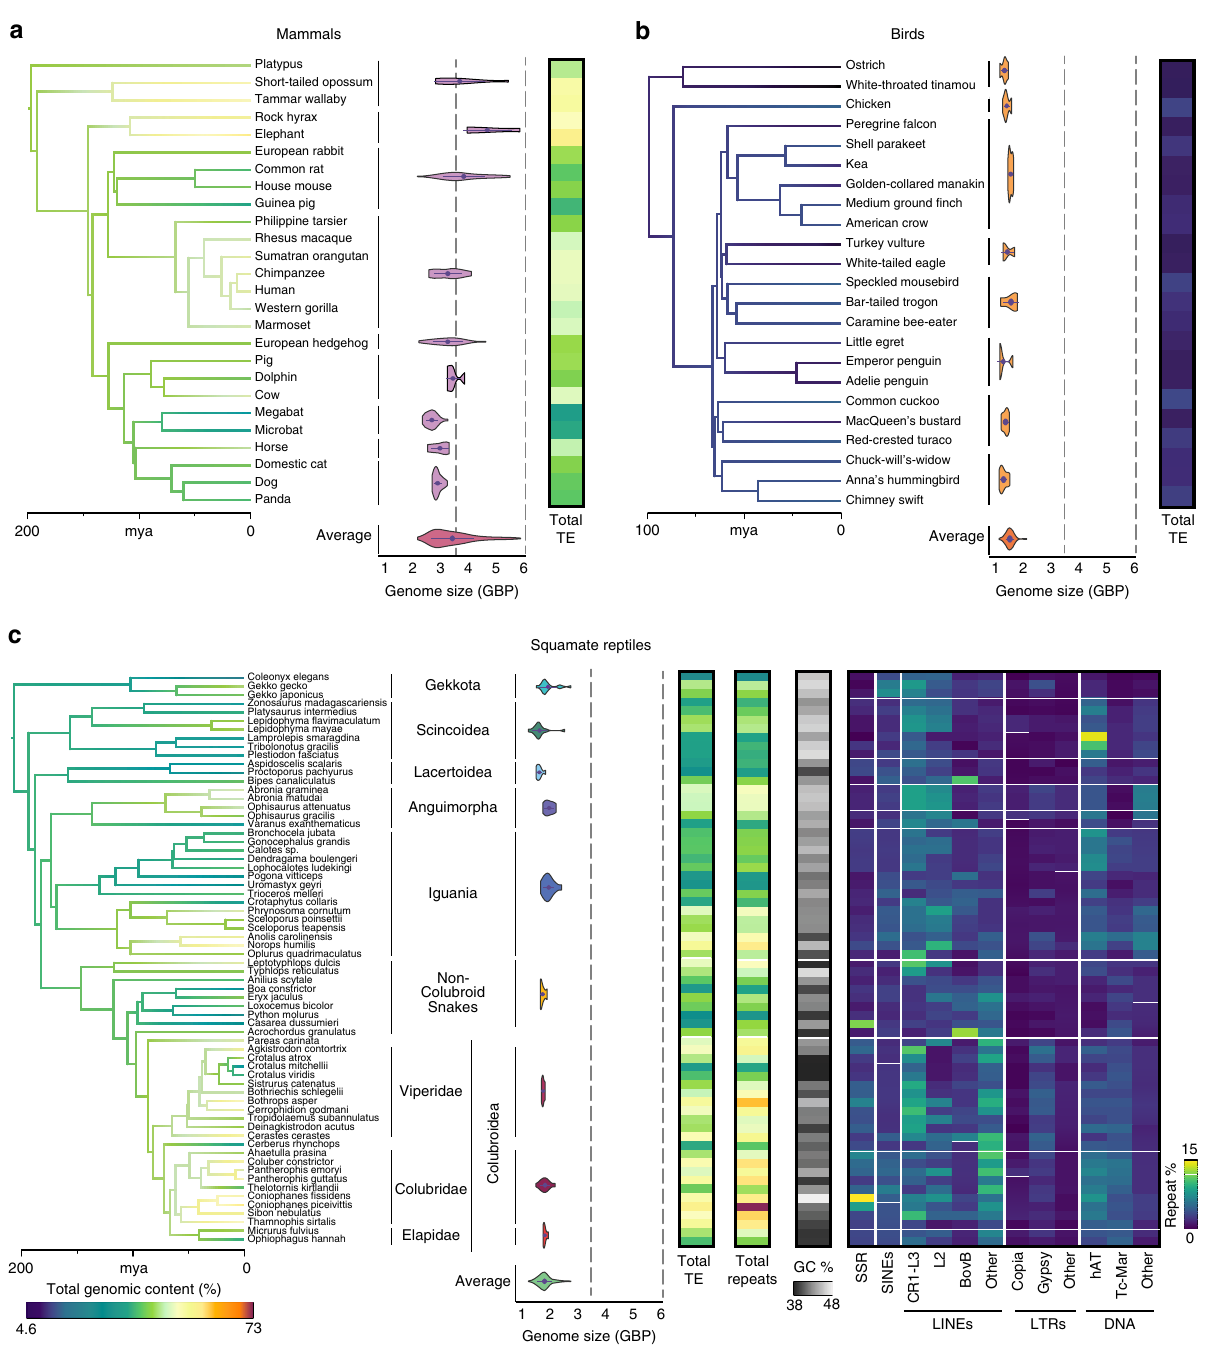
Fig. 1 Genomic transposable element (TE) abundance and genome size variation in mammals, birds, and squamate reptiles. Branches on the time- calibrated consensus phylogeny are colored according to the estimated rate of genomic TE evolution. Violin plots show distributions of fl ow cytometry- based genome size estimates for major groups of a mammals, b birds, and c squamate reptiles, and the associated heat maps re fl ect the total genomic TE content (%) for each taxon. For squamate reptiles, additional heat maps show percent genomic repeat element content, percent genomic GC content, and percentages of major components contributing to the overall repeat element